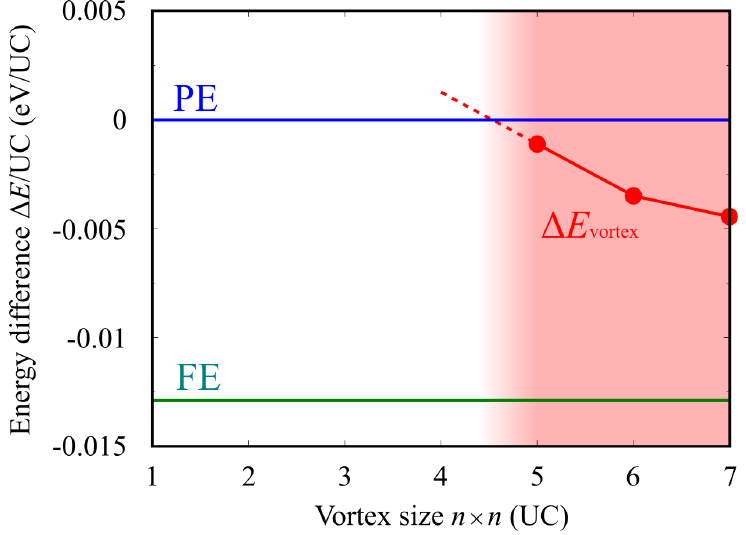
Figure 11. Total energy difference of the vortex polarization Δ E vortex and the ferroelectric phase of the SnTe monolayer on the basis of the paraelectric phase as a function of the size of vortex polarization. The increase in the total energy of vortex polarization due to the decrease in the size of vortices is due to the increase in domain wall densities. As shown in Figure 12, the vortex structure has four domains (white area), and they are separated by four 90° domain walls (green area). As the size of the vortex polarization decreases, the ratio of the domain wall per unit surface area increases, and the total energy increases. Such a high density of domain walls in the smaller vortex polarization is the primary cause of the loss of polarization in the smaller SnTe nanoflakes.